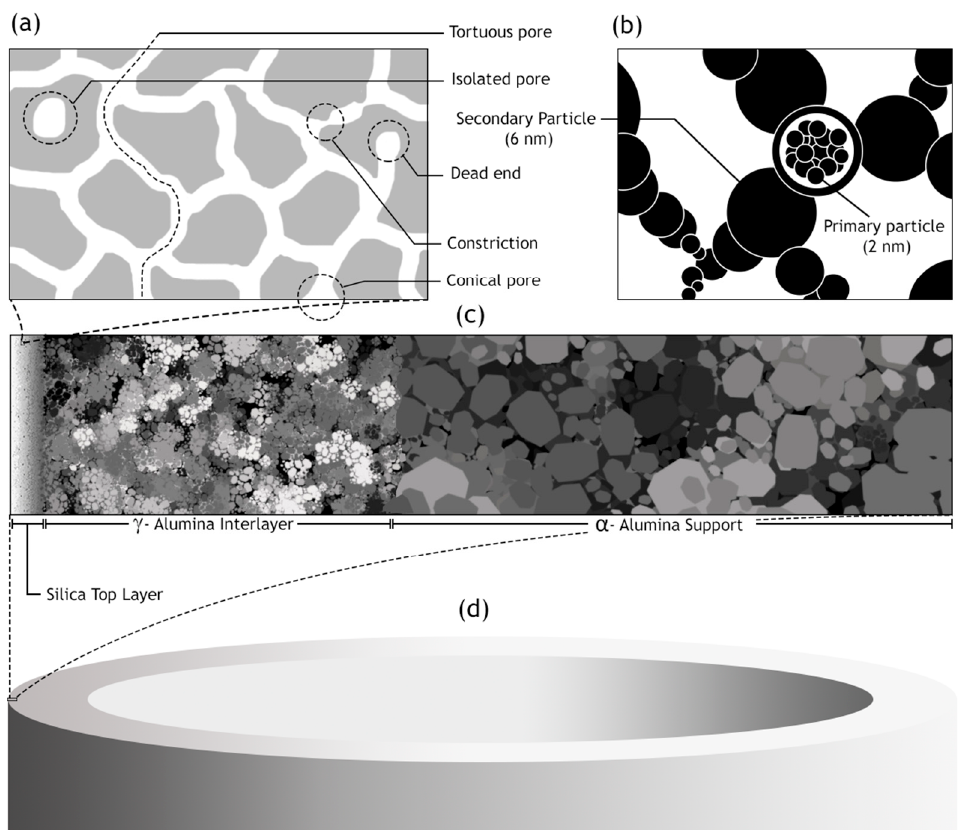
Figure 1. ( a ) Inset of the silica top layer depicting the various pore topologies and the associated nomenclature. ( b ) The agglomerated primary particles resulting in secondary particles, which are the building blocks of the porous network. ( c ) Inset of silica top layer supported by the γ -alumina interlayer and the α -alumina bas layer representing a typical tubular pervaporation module. ( d ) Illustration of a typical tubular pervaporation module.